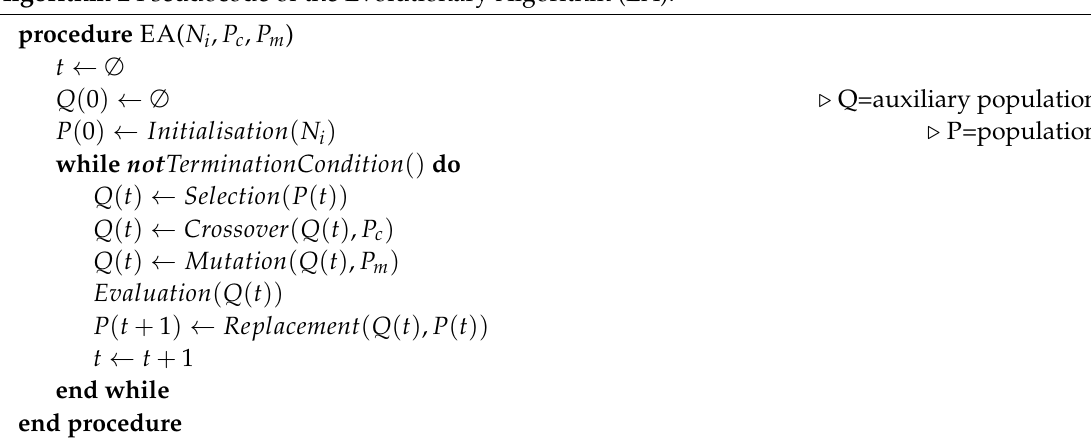
Algorithm 2 Pseudocode of the Evolutionary Algorithm (EA).